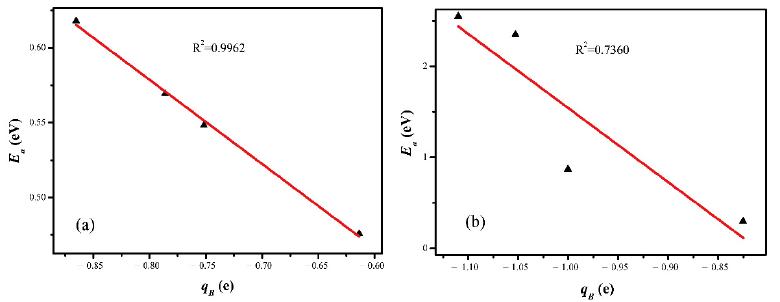
Figure 8. Trends in the CO 2 activation barrier ( E a ) as a function of the average Bader charge (q B ) of the involved surface Cu and doped metal atoms for the CO 2 hydrogenation to ( a ) COOH and ( b ) HCOO.